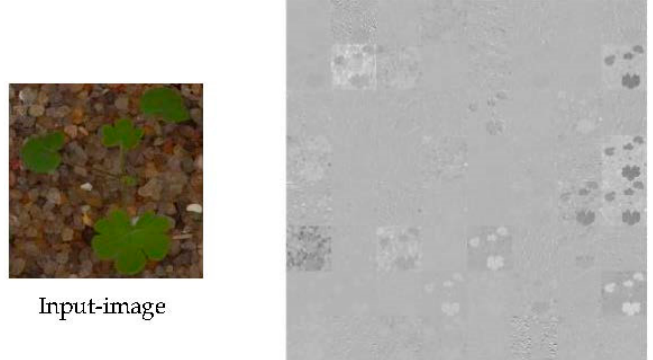
Figure 4. Visualization of activations of the first Conv-layer of Alexnet .